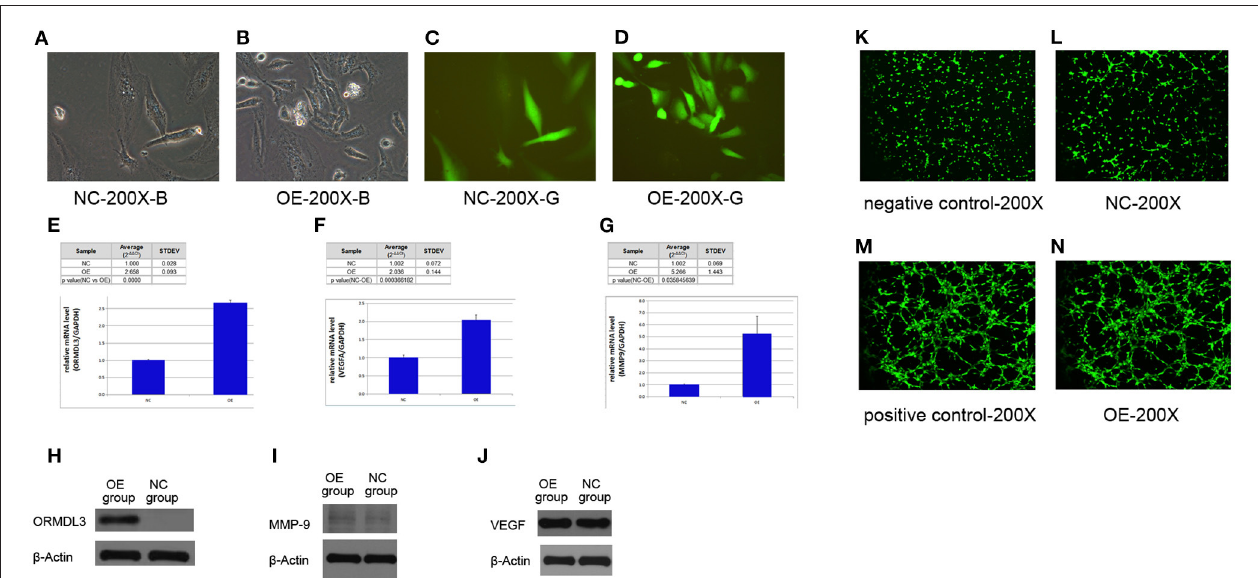
FIGURE 4 | Infection of the recombinant lentiviral vector into BEAS-2B cells. The plasmids were introduced into BEAS-2B cells, the lentiviral vector overexpressing ORMDL3 was successfully constructed and effectively infected BEAS-2B cells. Fluorescence rate was the positive infection rate (A–D). OE (B,D) : the group infected with the lentiviral vector overexpressing ORMDL3 NC (A,C) : the normal group. Magnification, × 200 (B is bright field, G is the fluorescence field). (E–G) ORMDL3, VEGF, and MMP-9 mRNA expression in ORMDL3-overexpressed BEAS-2B cells. In the infected BEAS-2B cells with the ORMDL3-overexpressed lentiviral vector, the mRNA expressions of angiogenesis biomarkers (VEGF/MMP-9) were increased compared with that in the control group. The quantitative PCR results show that the ORMDL3 gene expression in the OE group was 2.658 times that in the NC group ( P = 0.0000) (E) ; the VEGF expression in the OE group was 2.036 times that in the NC group ( P = 0.000366182) (F) ; MMP-9 gene expression in the OE group was 1.443 times that in NC group ( P = 0.035845639) (G) . (H–J) VEGF, MMP-9, and ORMDL3 protein expression in ORMDL3-overexpressed BEAS-2B cells. (H) ORMDL3 expression, (I) MMP-9 expression, (J) VEGF expression. In the infected BEAS-2B cells with the ORMDL3-overexpressing lentiviral vector, the protein expressions of ORMDL3 and angiogenesis biomarkers (VEGF/MMP-9) were progressively increased compared with that in the control group. (K–N) Tube formation assay. (K) Negative control, (L) NC, the negative-infected group; (M) PC, positive control; (N) OE, the positive infected group with the ORMDL3-overexpressing lentivirus. Magnification, × 200. There is no difference between the NC and OE